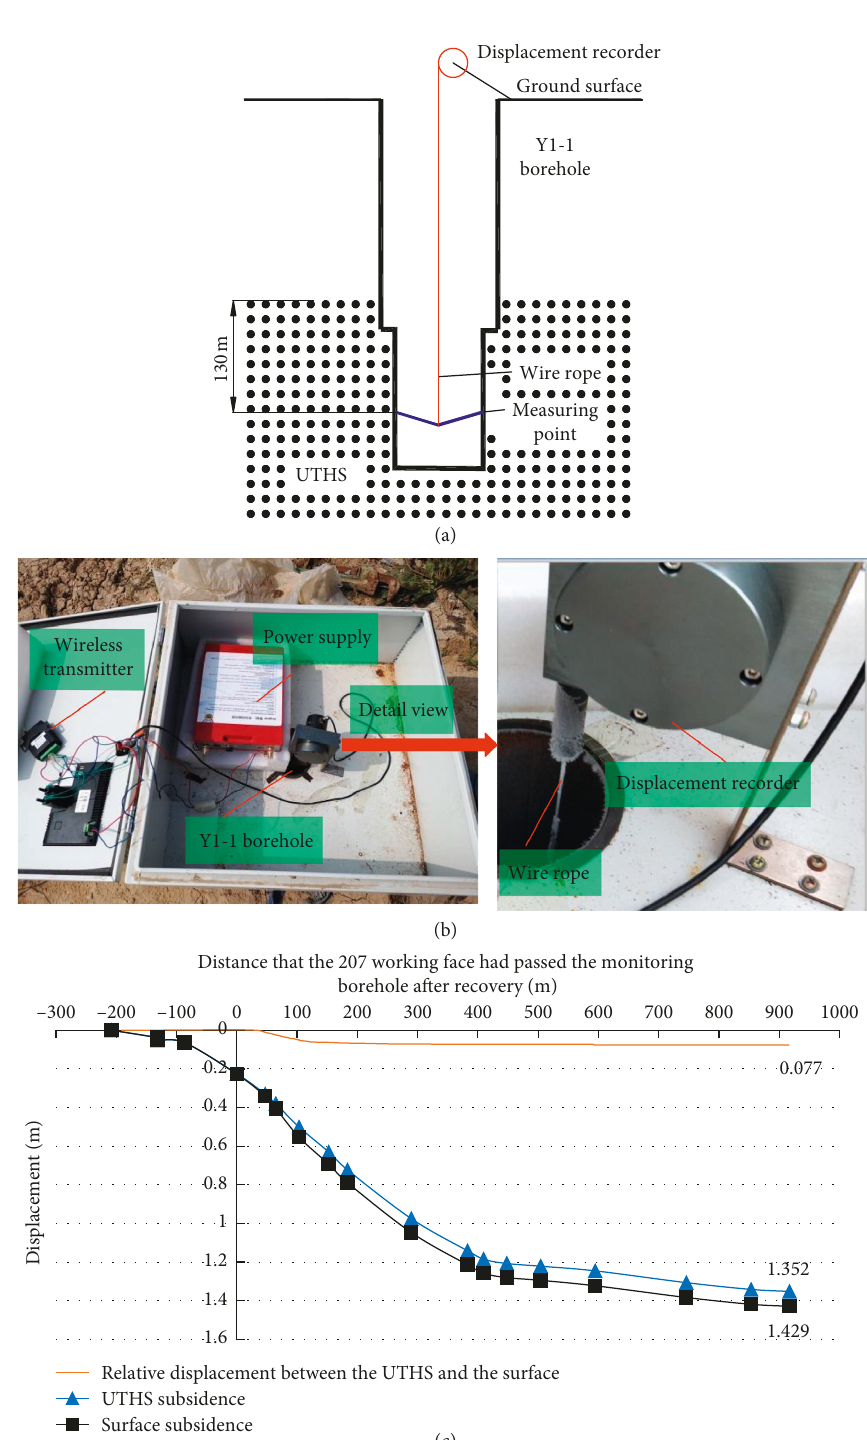
Figure 4: Subsidence monitoring of surface and UTHS after recovery of the 207 working face. (a) Schematic diagram of UTHS subsidence monitoring drill hole. (b) UTHS subsidence monitoring equipment. (c) UTHS and surface subsidence